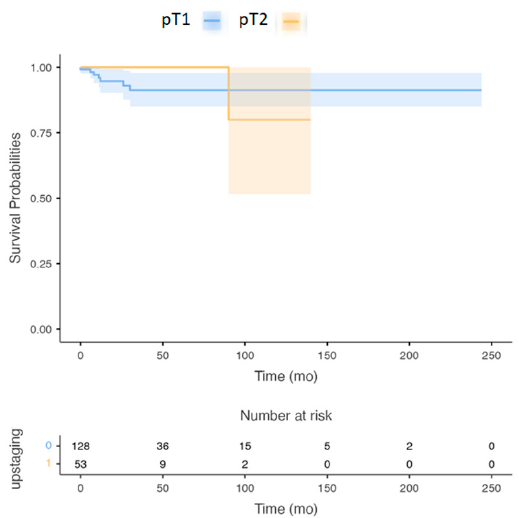
Figure 1. Survival Curve: Overall survival of pT1 and pT2 patients with the seventh AJCC staging system versus eighth AJCC staging system. ( p -value > 0.05). Group (2): The OS of patients upstaged to pT3 (from pT1, pT2N0M0) was 94% (CI: 89–96%), compared with 92% (CI:89–97%) in patients who remained in pT1 and pT2 N0M0 ( p -value = 0.082, Figure 2).